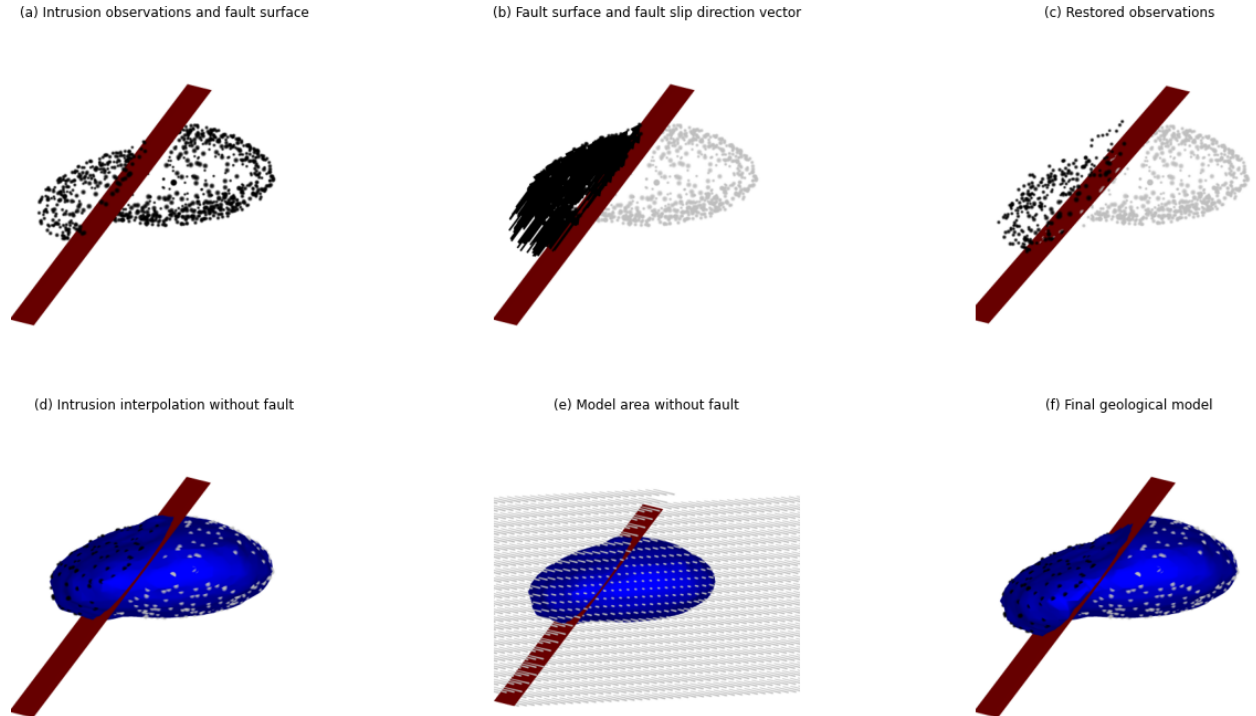
Figure 7. Case study showing faulted 3D intrusion. (a) Observations of the intrusion surface (black points) and modelled fault surface (red surface). (b) Fault restoration vector evaluated on data point locations showing the restoration direction. (b) Restored data points from A. (d) Intrusion surface interpolated in restored domain showing data points and fault surface. (e) Regular grid highlighting restoration function on model domain, where the hanging wall points have been restored. (f) Fault and faulted intrusion surfaces.